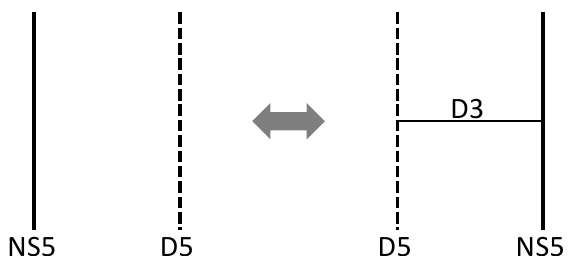
Figure 1 . The simplest example of the Hanany-Witten transition. After the exchange of two 5-branes, a D3-brane is